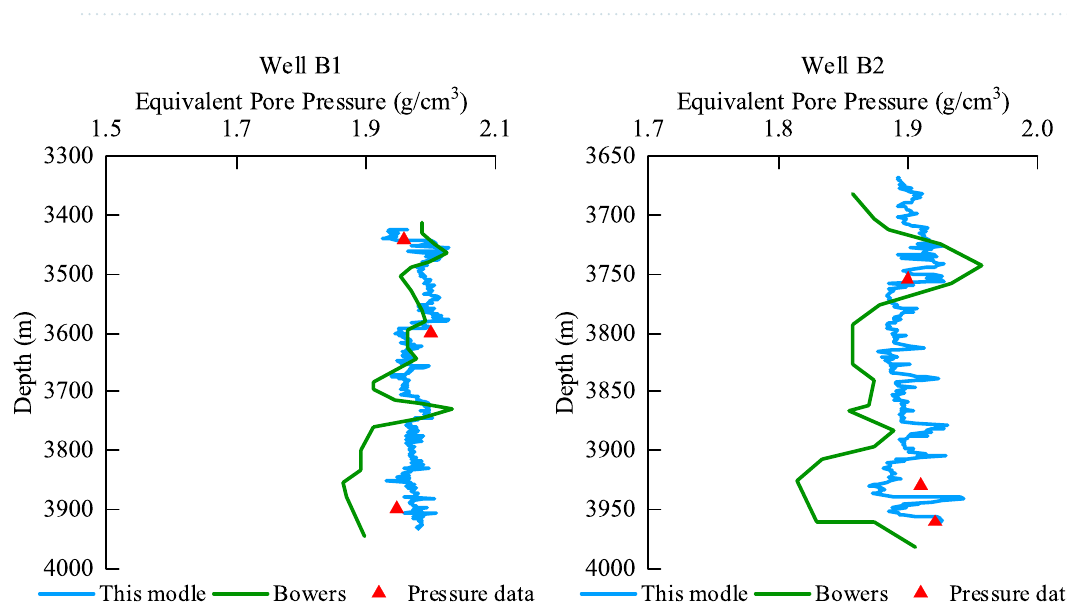
Figure 13. Comparison of loading modeling prediction results.